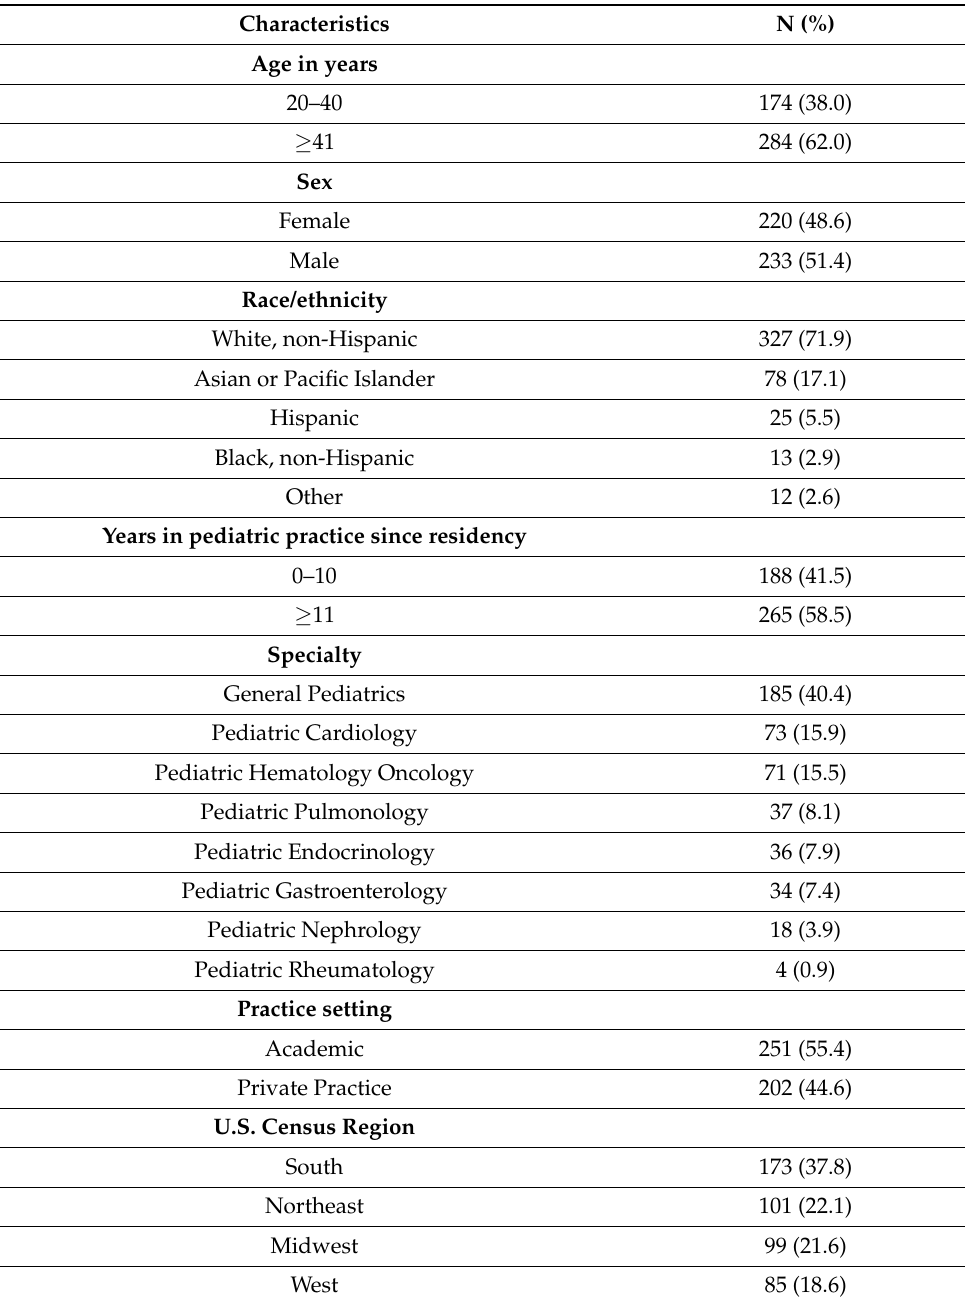
Table 1. Characteristics of Participating Pediatricians (N =